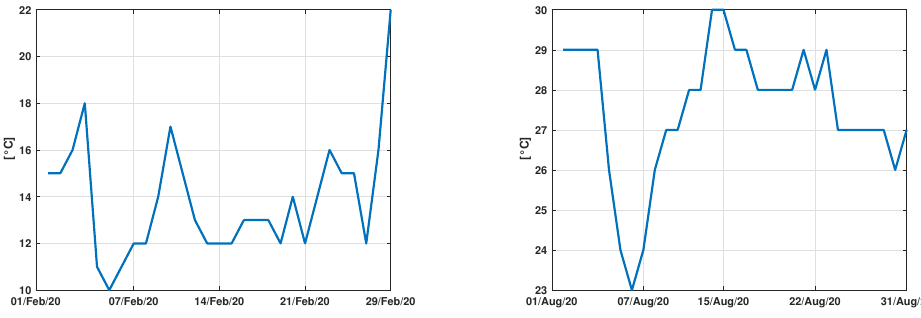
Figure 19. Site 2—Atmospheric temperature averaged values: February 2020 ( left ) and August 2020 ( right